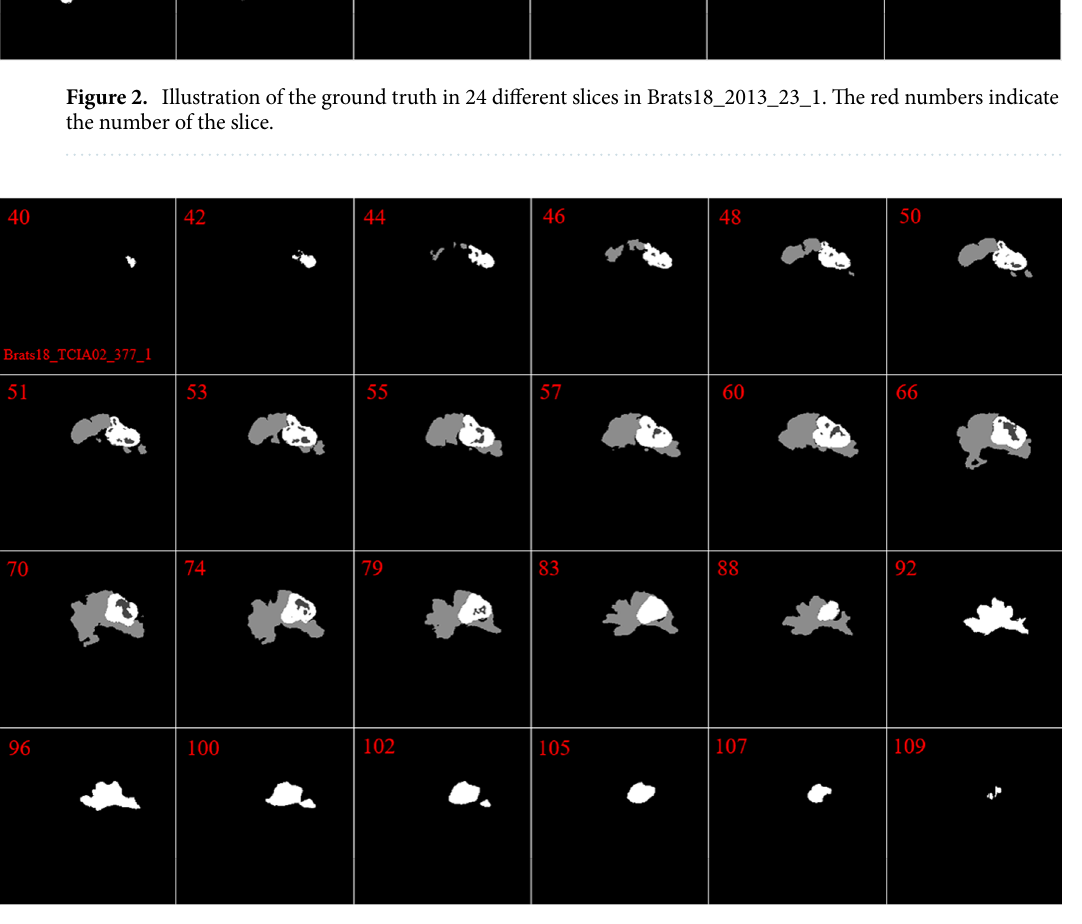
Figure 3. Demonstration of the ground truth in 24 different slices in Brats18_TCIA02_377_1. The red numbers indicate the number of the slice. Different parts of tumor are illustrated with different